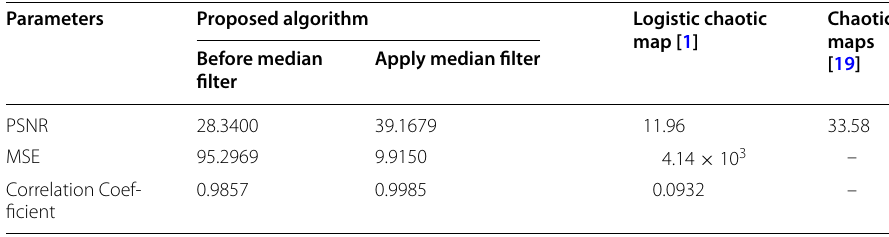
Table 6 Salt and pepper noise